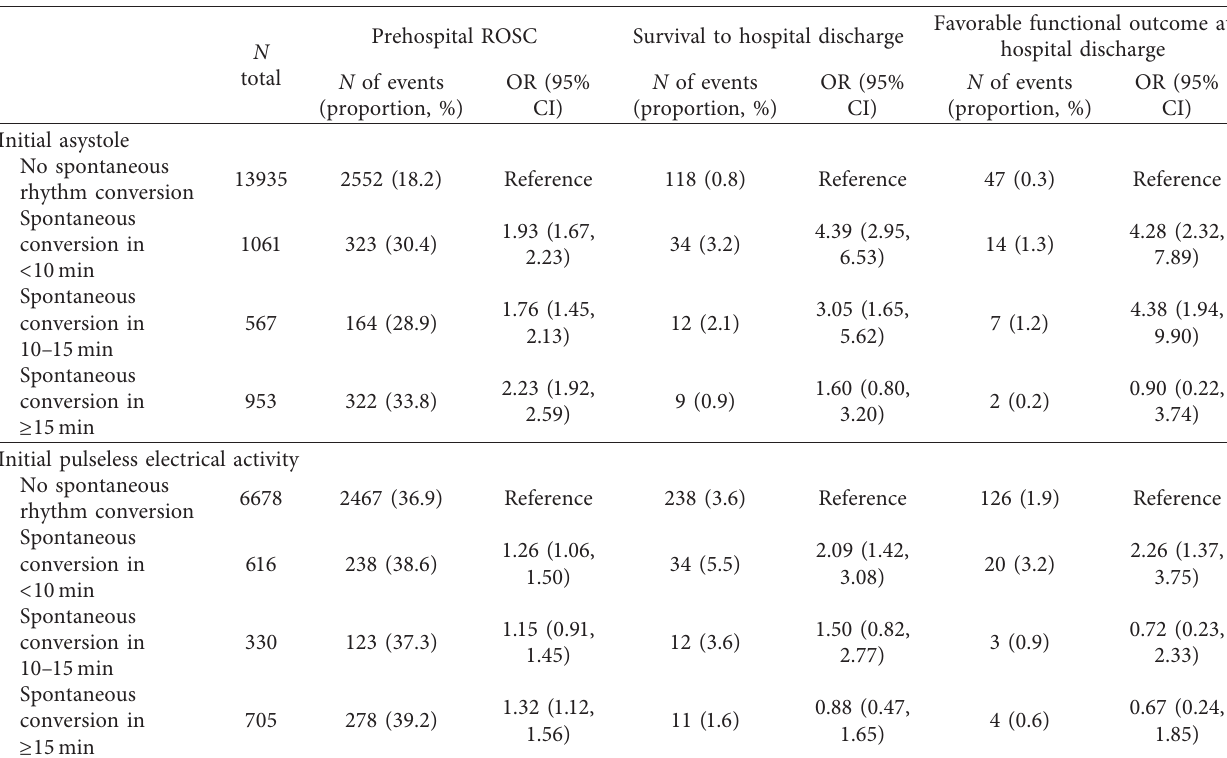
Table 2: Results from multivariable logistic regression analysis, assessing the associations of spontaneous rhythm conversion with prehospital ROSC, survival to hospital discharge, and favorable functional outcome in initial nonshockable rhythm OHCA stratifying by time of spontaneous shockable rhythm